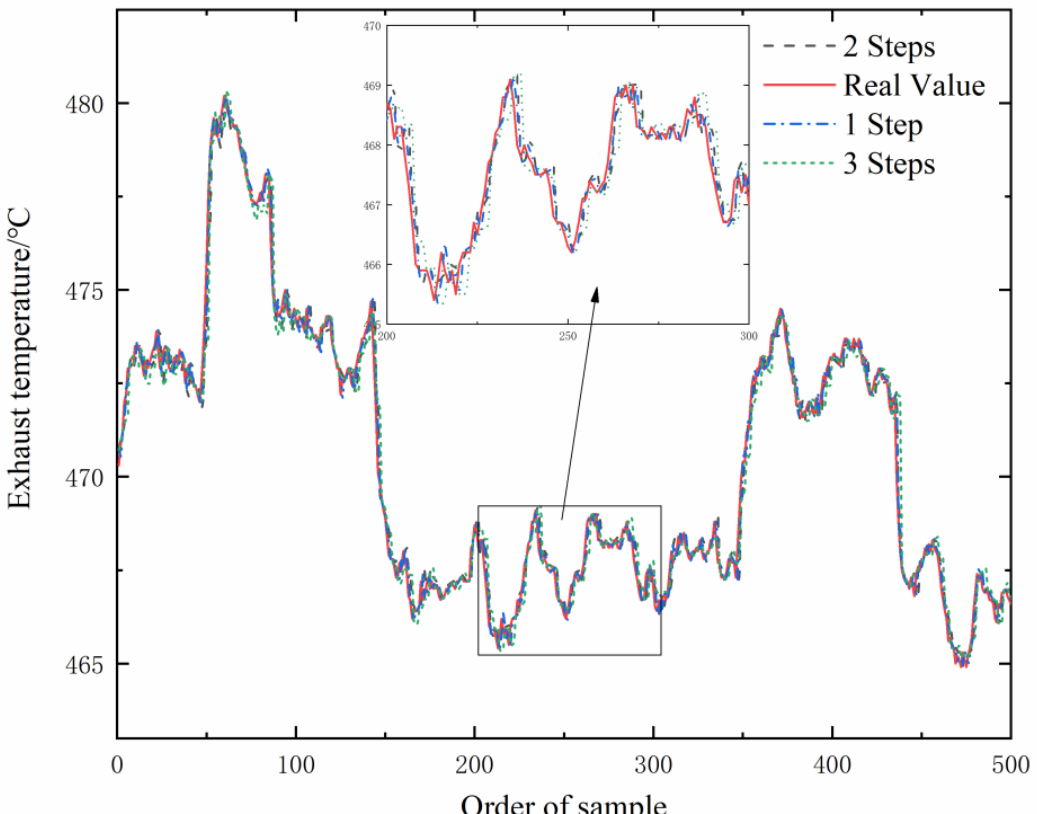
14 of 22 Figure 8. Prediction result residual value box plot.